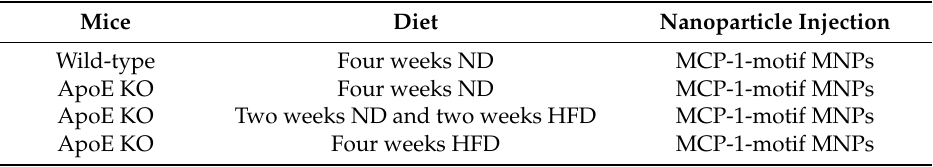
Table 1. Experimental design of animal model for magnetic resonance imaging (MRI).